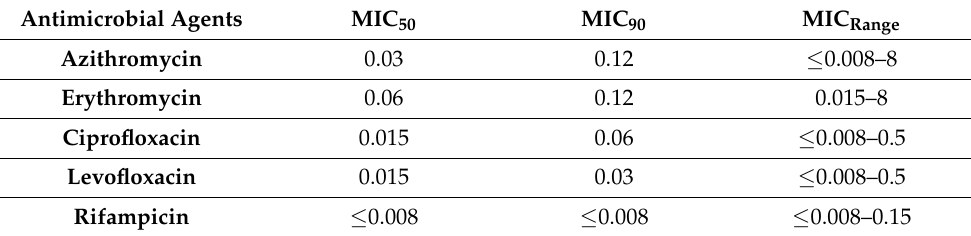
Table 2. MIC Range , MIC 50 , and MIC 90 values (mg/L) for 58 environmental isolates of Legionella pneumophila . Antimicrobial Agents MIC 50 MIC